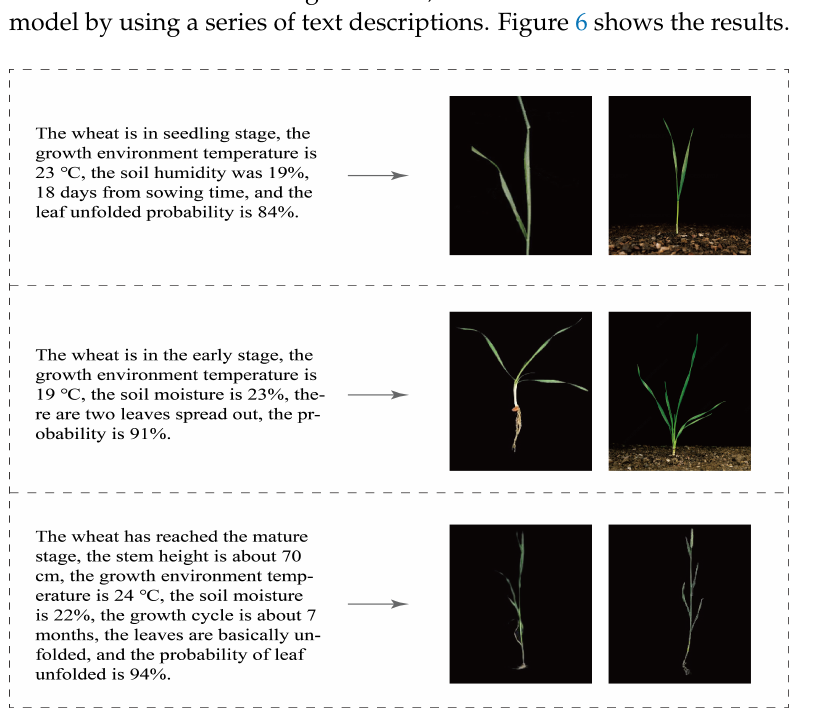
Figure 6. The test results of the text-to-image model: the model can generate a variety of images based on the text